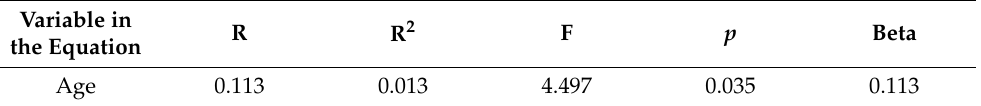
Table 10. Step-wise multiple regression based on personal aspects: dependent variable job satisfaction. Variable